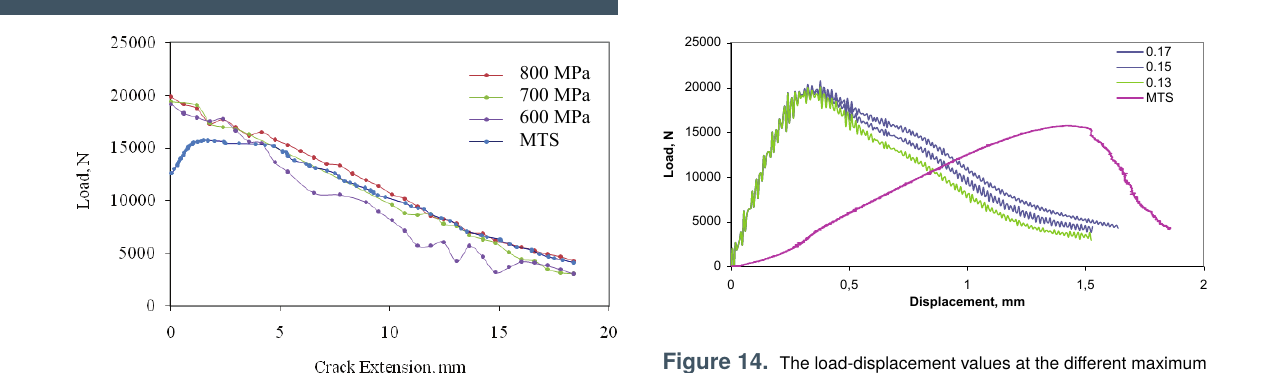
Figure 14. The load-displacement values at the different maximum displacement jump and the comparison with the experi- Figure 12: The load-crack extension values at the different maximum strength of the cohesive element and the comparison with the mental data. Figure 12. The load-crack extension values at the different maxi- experimental data. mum strength of the cohesive element and the compar- 4.4 Sensitivity of Displacement Jump ison with the experimental data. The cohesive theories describe the evolution of a fracture as the progressive separation of two surfaces which is described by the displacement jump δ (shown in figure 13) between two points, originally coincident, on the two cohesive surfaces. In the finite kinematics, the displacement jump is computed as the difference of the displacement field φ on the two facing surfaces (here the superscripts + and – denote the two opposite surfaces): = φ + + φ -